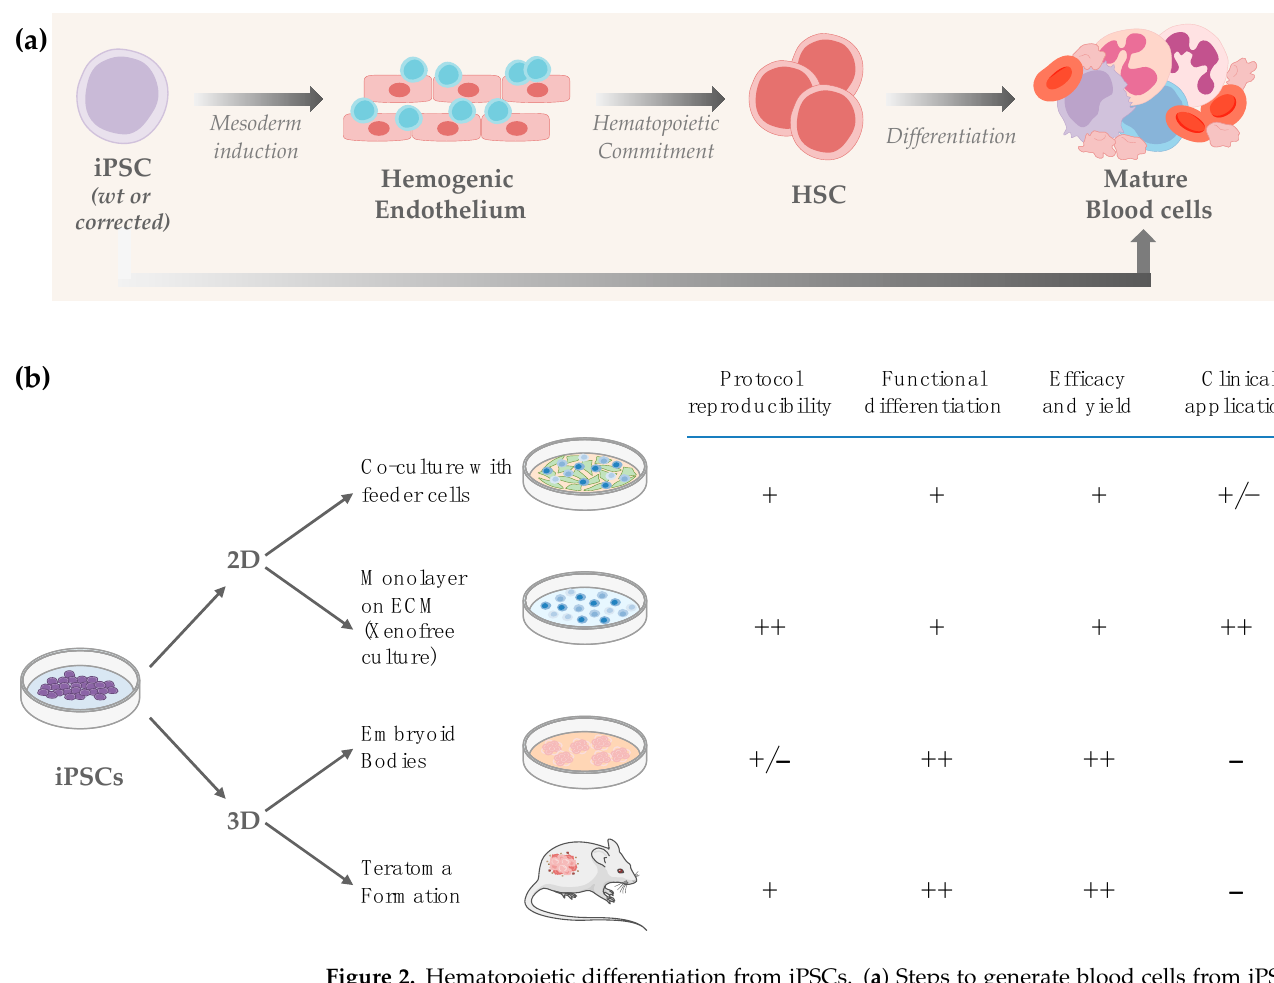
Figure 2. Hematopoietic differentiation from iPSCs. ( a ) Steps to generate blood cells from iPSCs. The HSC stage occurs during definitive hematopoiesis; ( b ) Strategies to generate blood cells from iPSCs. Symbols indicates absence ( − ), low (+/ − ), moderate (+), or strong (++) compliance with the highlighted features (protocol reproducibility, functional differentiation, efficacy, yield and clinical application).